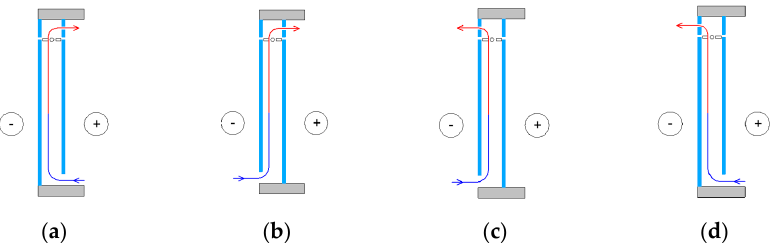
Figure 9. Scheme of double-skin façade operation ( a ) mode A, ( b ) mode B, ( c ) mode C, ( d ) mode D (data from ref. [34,106,107]).